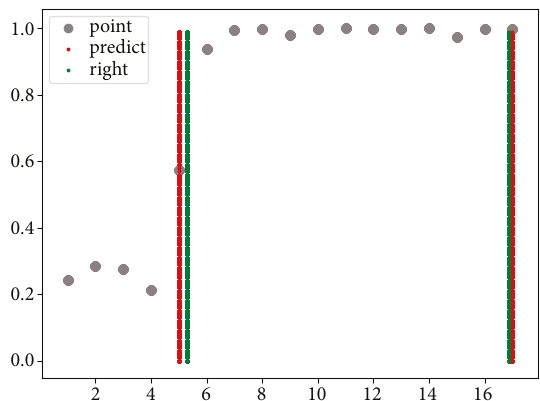
Figure 5: Example of postprocessing in audio announcement detection.